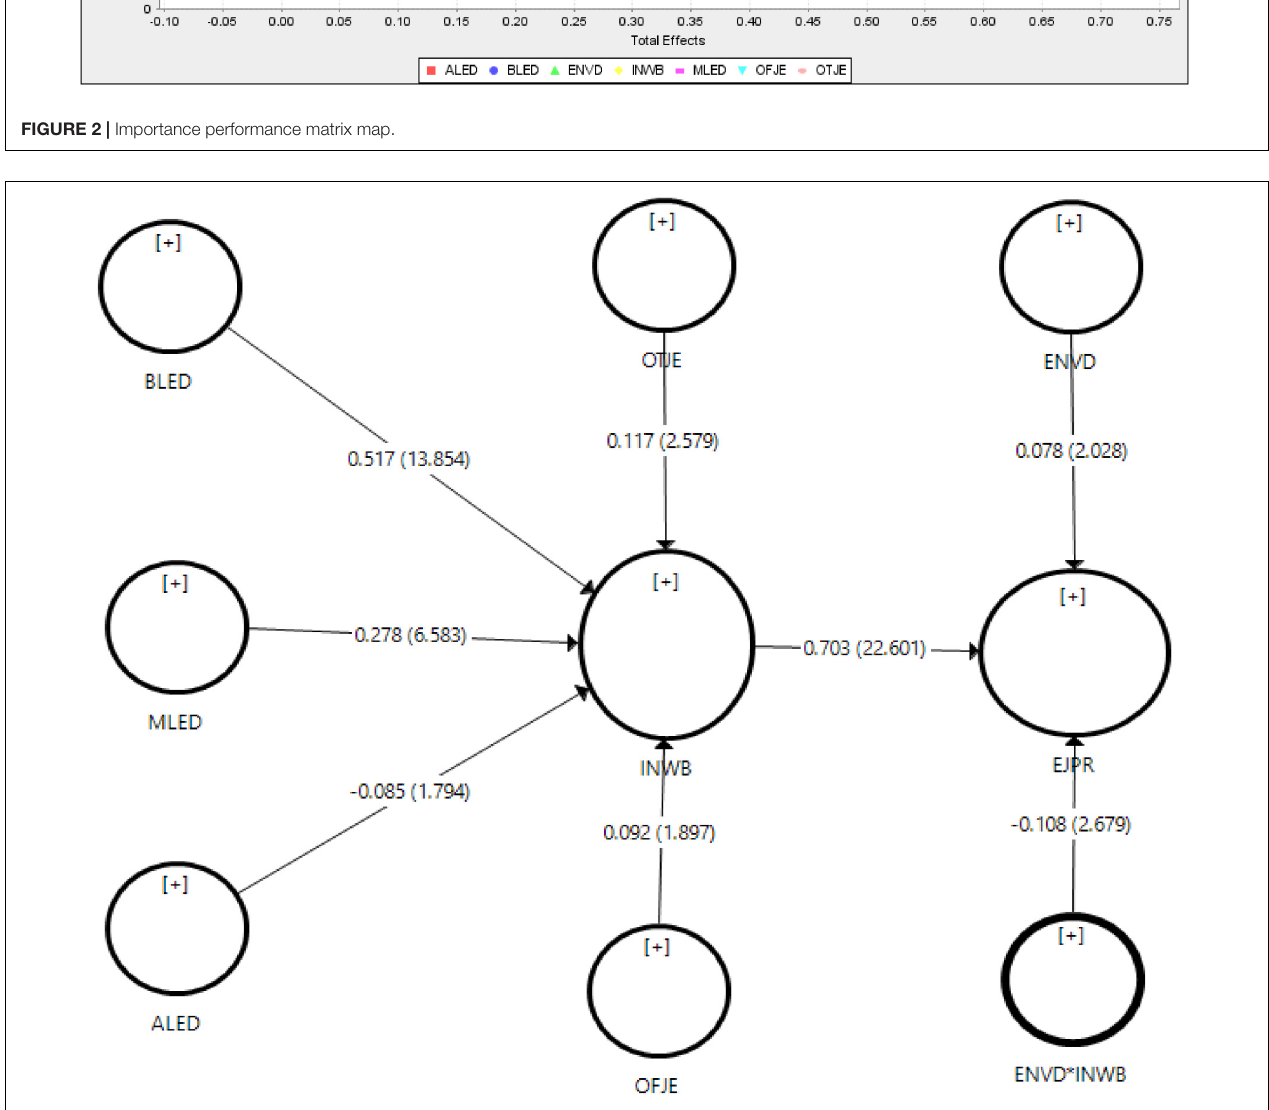
FIGURE 3 | Moderating effect of environmental dynamism.